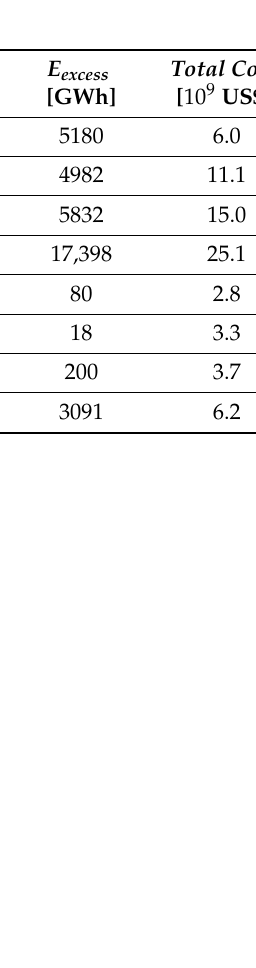
Figure 5. Illustration of the effect of using thermal storage vs. electric battery storage. The difference in system cost grows larger with the renewable energy share target as defined in Equation (2) X RES .